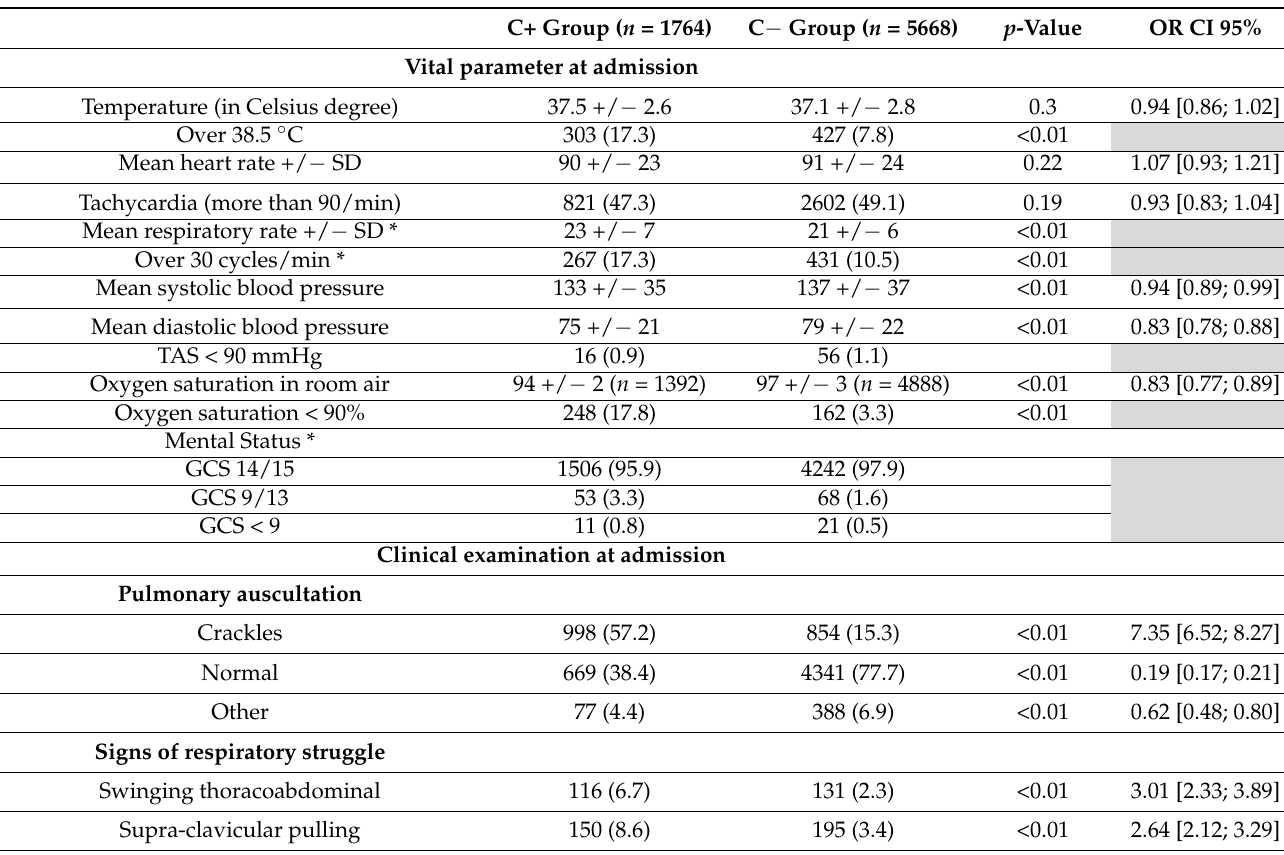
Table 4. Vital parameters and clinical examination at admission. (Description of missing data by variable in Table